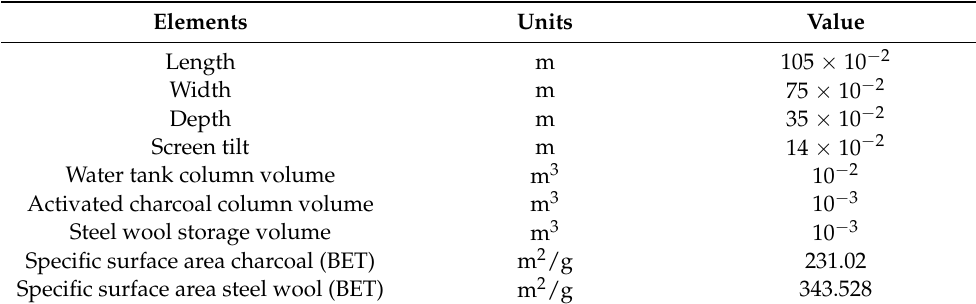
Table 3. Dimensions and capacities of purification system.